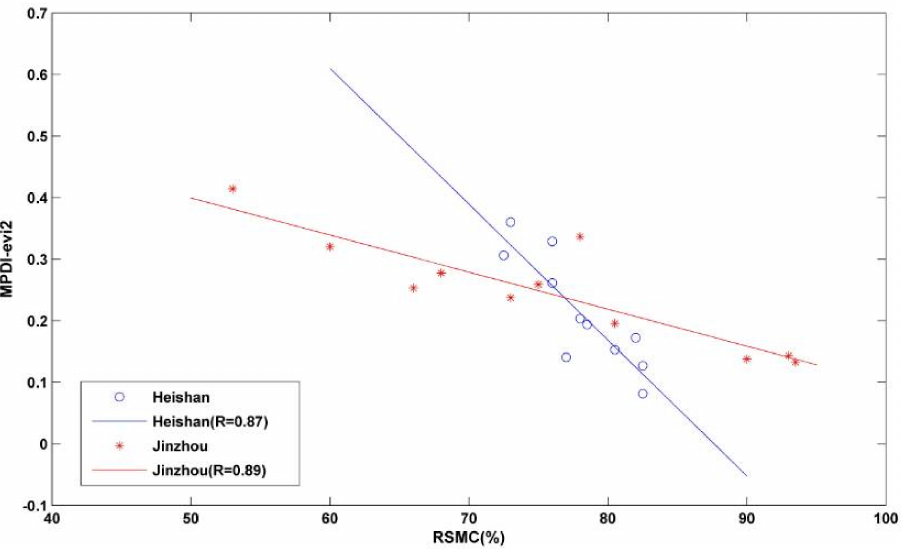
Figure 5. Scatter plot of MPDI_evi2 with RSMCs measured at the Heishan and Jinzhou agro- meteorological